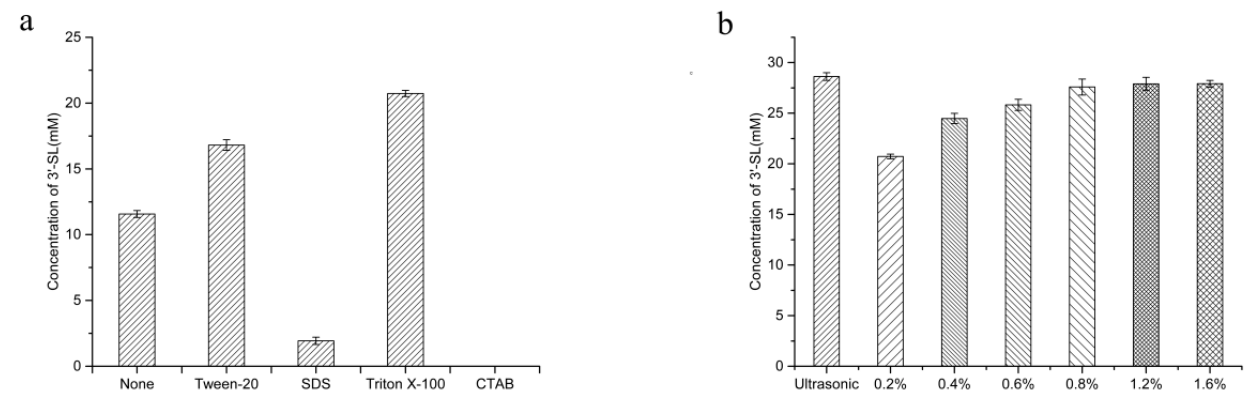
Figure 5. Effect of surfactants on 3 ′ -SL concentration. ( a ) Effect of different surfactants on 3 ′ -SL concentration; ( b ) effect of different contents of Triton X-100 on 3 ′ -SL concentration.